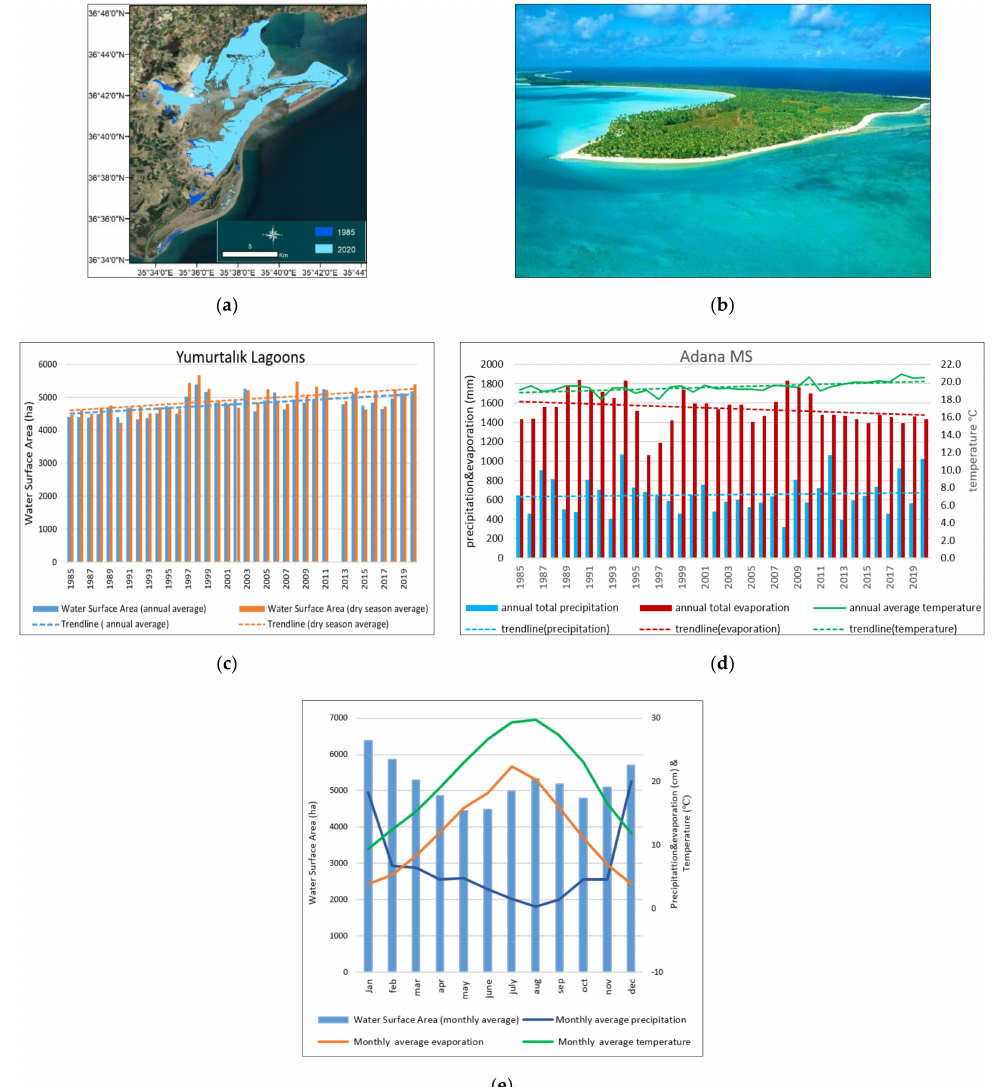
Figure 7. Yumurtalık Lagoons: ( a ) Lagoons’ Location and 1985 And 2020 Annual Average Water Surface Areas (NDWI > 0); ( b ) View of Lagoons [54]; ( c ) 1985–2020 Period, Water Surface Areas (Annual Averages and Dry Season Averages); ( d ) Adana Meteorological Station Data (Annual Total Precipitation, Total Evaporation, and Average Air Temperature); ( e ) 2016–2020, Monthly Average Water Surface Areas, Precipitation, Evaporation and